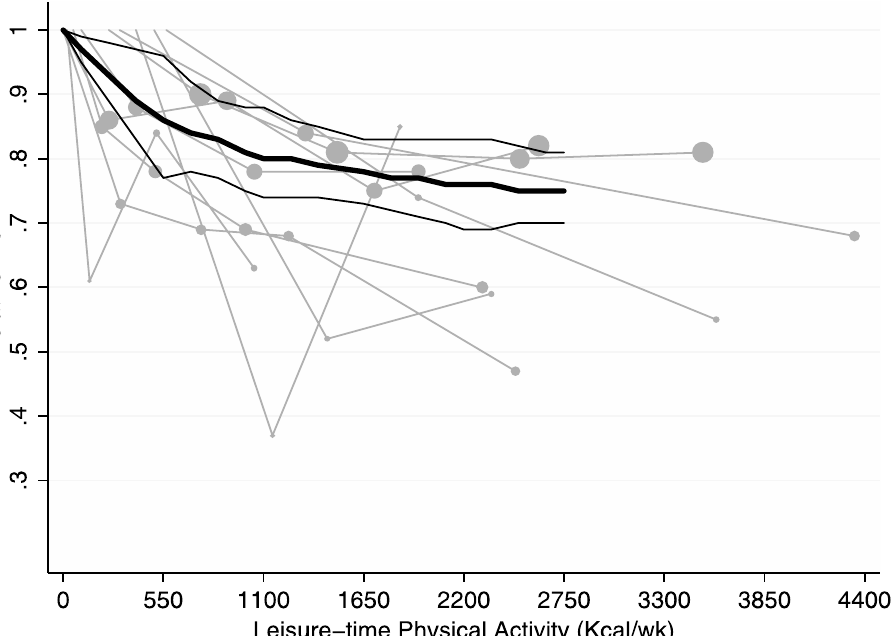
Note: Individual study results are plotted with grey lines; the thick black line shows the trend line for both sexes combined from a random spline-fit model and the thinner black lines show the 95% CI for the trend. Source: Sattelmair et al., 2011, 23 Dose response between physical Activity and Risk of Coronary Heart Disease, a Meta-Analysis, Circulation, 124: 789-795.